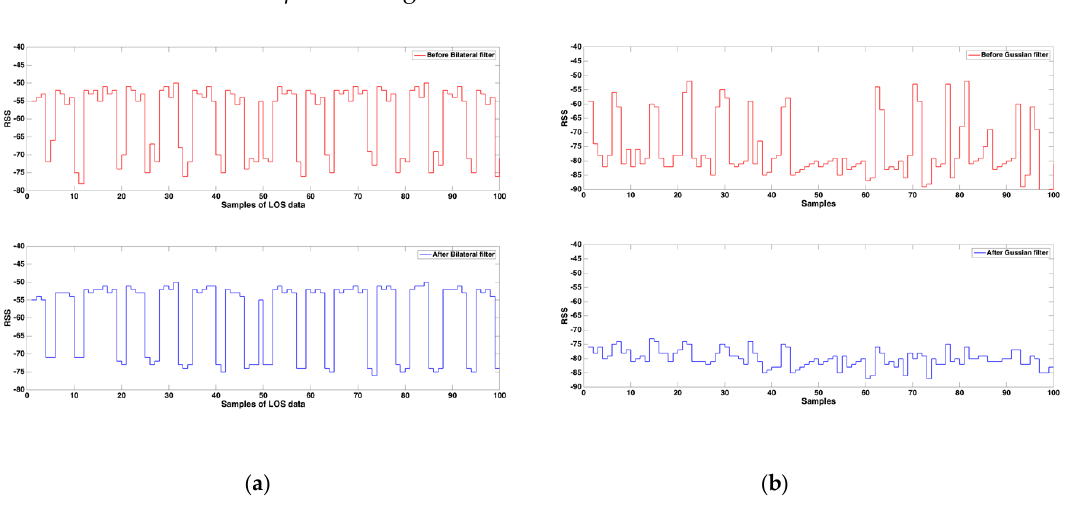
Figure 5. The filtering demonstration of ( a ) Bilateral filter for the LOS, and ( b ) Gaussian filter for the NLOS data.